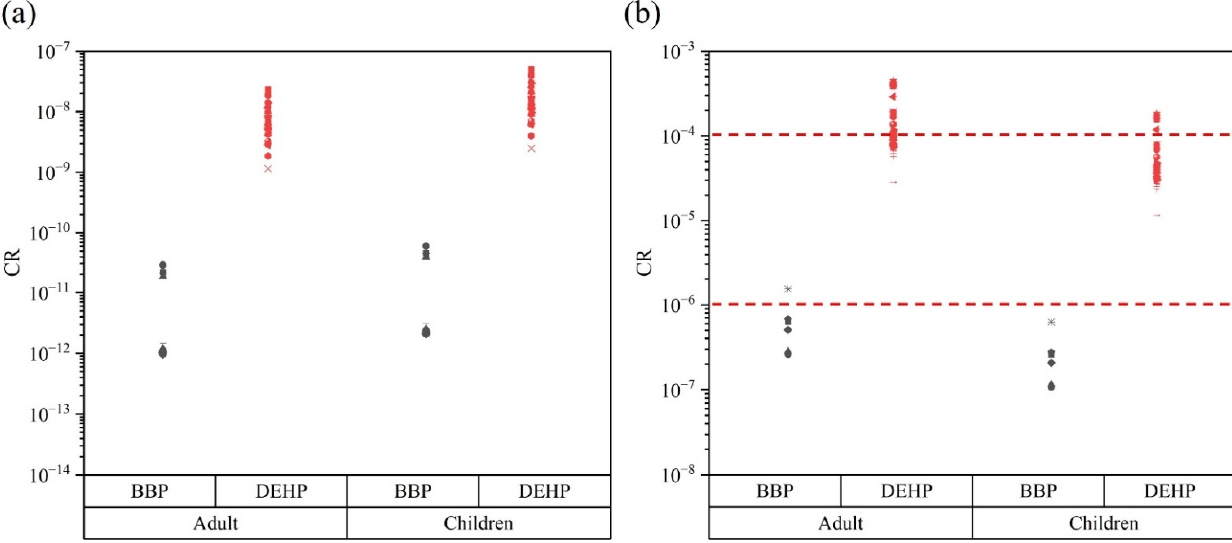
Figure 4. The carcinogenic risk values (CR) were calculated to assess the potential carcinogenic risk due to BBP and DEHP in soil–plant systems. The dots represent the CR values for the potential carcinogenic risk of BBP and DEHP at each sampling site. Nondietary carcinogenic risk for adults and children ( a ). Dietary carcinogenic risk for adults and children ( b ). The auxiliary lines with CR values of 10 −6 and 10 −4 .